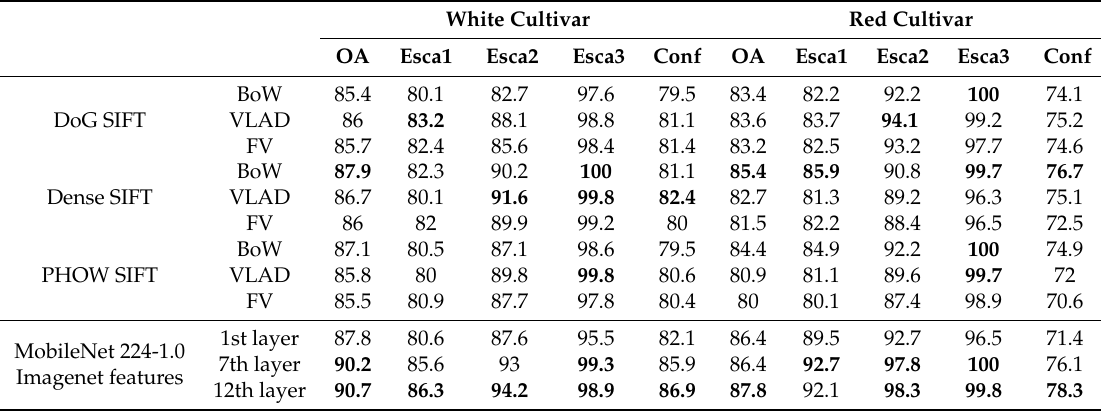
Table 4. Summary of best mean performances (%) for the whole dataset (OA), esca subclasses (esca1–esca3) and the confounding factors class (Conf) using 10 different train/test runs with balanced classes. Mean standard deviation for all results is around 1.6%. Bold values indicate best results for both extractor families. RGB, HSV and hue images were considered for SIFT based extractors and only the best result is displayed. Max pooling, average pooling and a combination of these two were also considered for deep learning based descriptors.